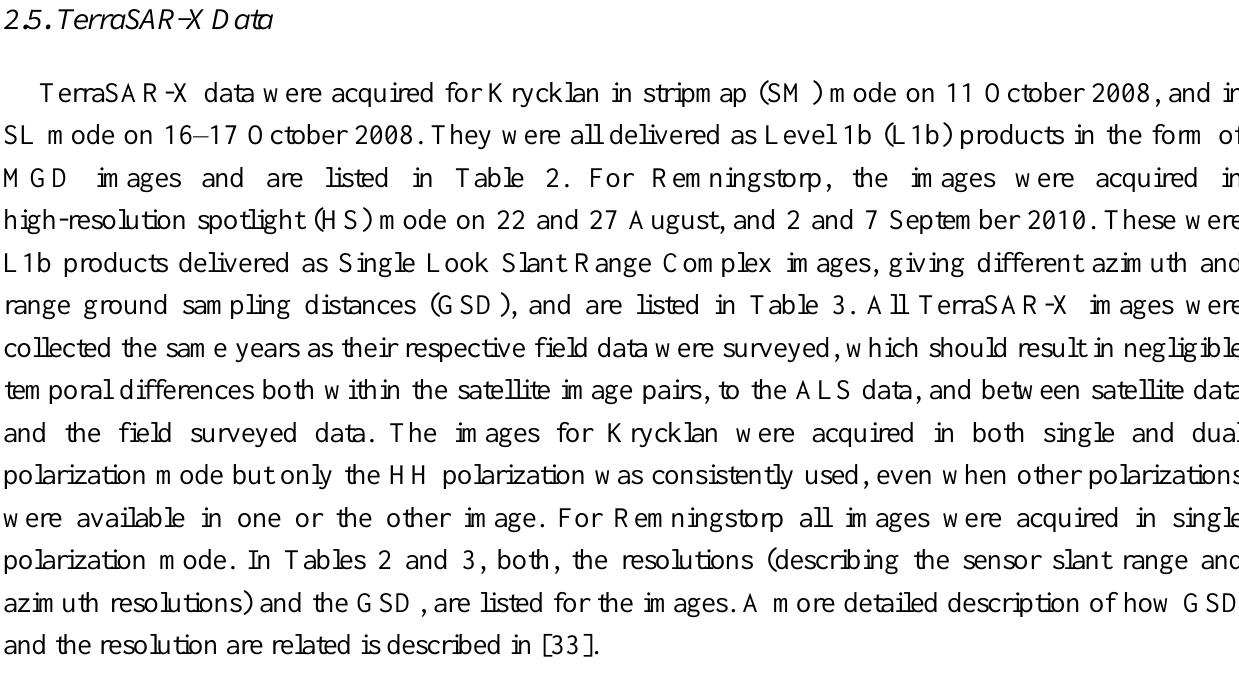
Table 2. The list of TerraSAR-X satellite images used for the Krycklan (KR) test